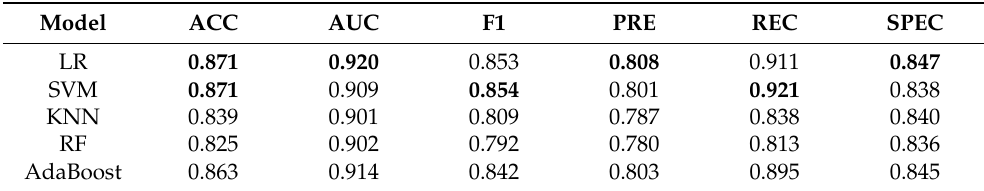
Table 7. Computational results for TCGA dataset with LASSO feature selection method and individ- ual models.